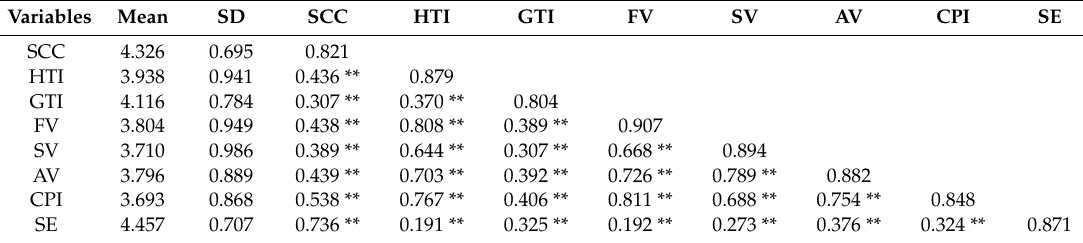
Table 5. Mean, standard deviation, and correlation